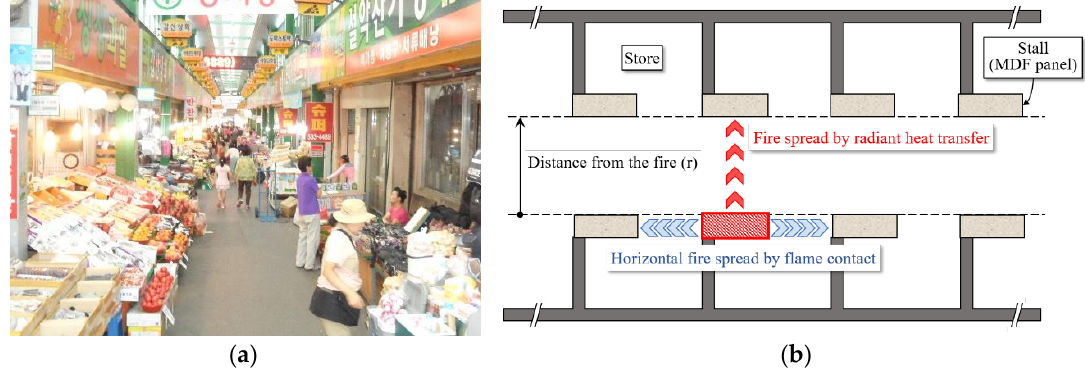
Figure 1. General structure of the passage-type traditional markets and fire spread path: ( a ) Photo of passage-type traditional market; ( b ) fire spread path in the traditional markets.